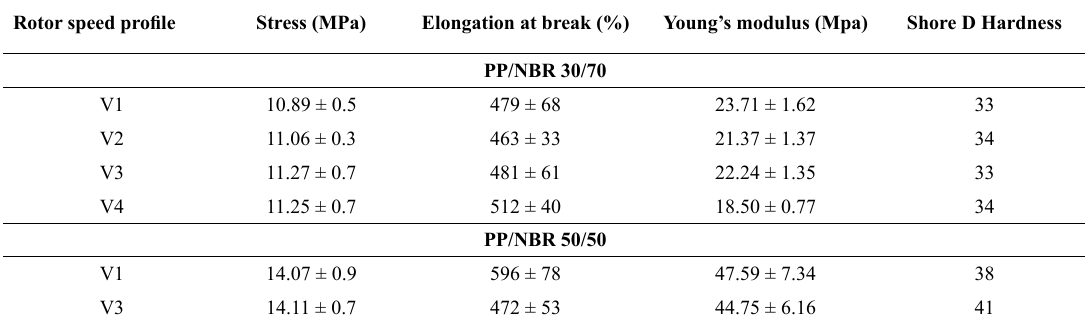
Figure 5. Schematic representation of the proposed mechanism of interaction between BMI and mixture components. Table 3. Mechanical properties of TPVs as a function of rotor